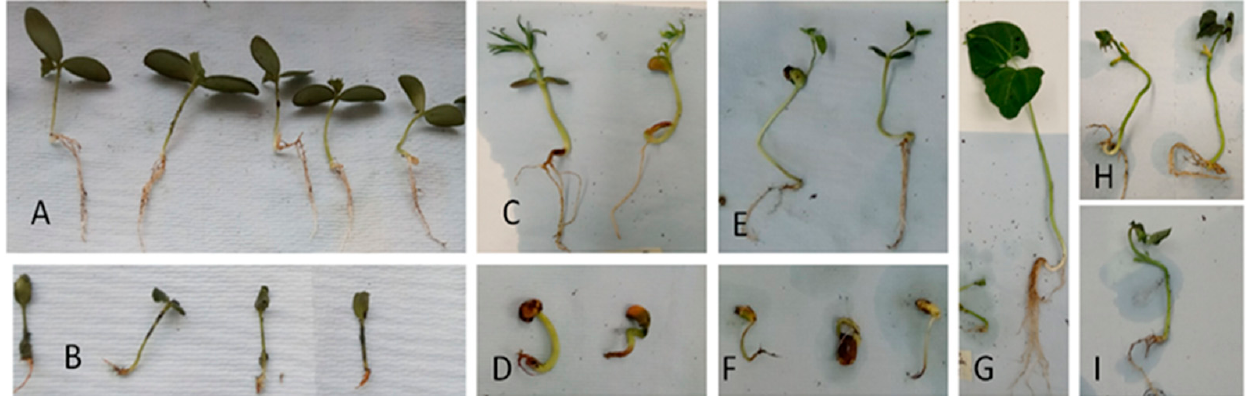
Figure 4. Pathogenicity indices of four plant species inoculated with Py. kashmirense . In vivo assay. ( A ) Cucumber-control, ( B ) Cucumber-inoculated, ( C ) Blue lupin-control, ( D ) Blue lupin-inoculated, ( E ) Soya bean-control, ( F ) Soya bean-inoculated, ( G ) Common bean-control, ( H–I ) Common bean-inoculated.